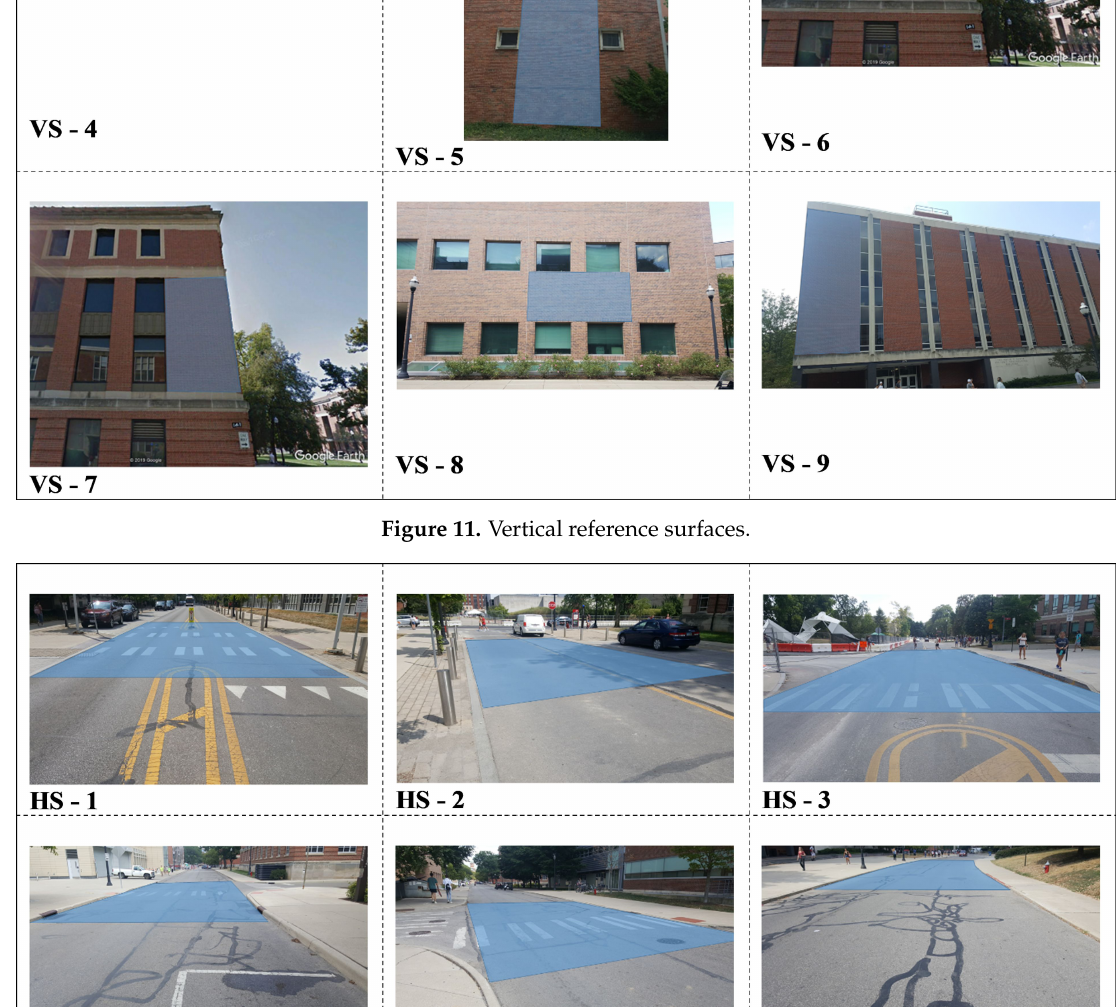
Figure 12. Horizontal reference